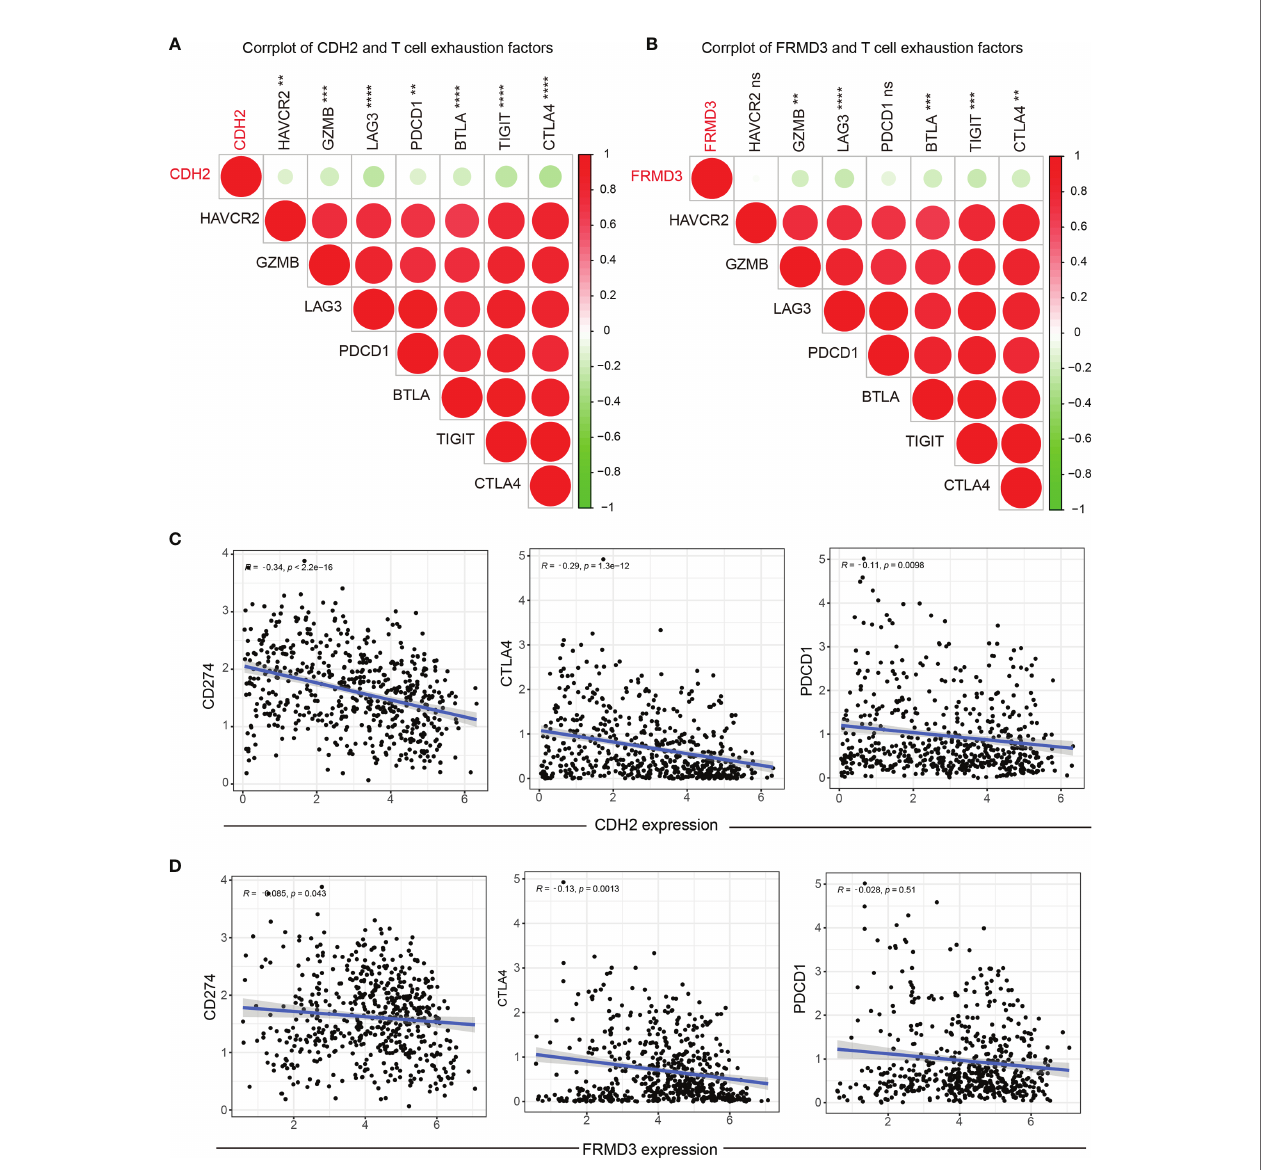
FIGURE 8 | Association of CDH2 and FRMD3 with immune checkpoints. (A, B) Correlation between T cell exhaustion factors and CDH2 (A) and FRMD3 (B) . (C, D) The association between CD274, PDCD1, CTLA4 and CDH2 (C) and FRMD3 (D) . **P < 0.01; ***P < 0.001; ****P < 0.0001; ns, no signi fi